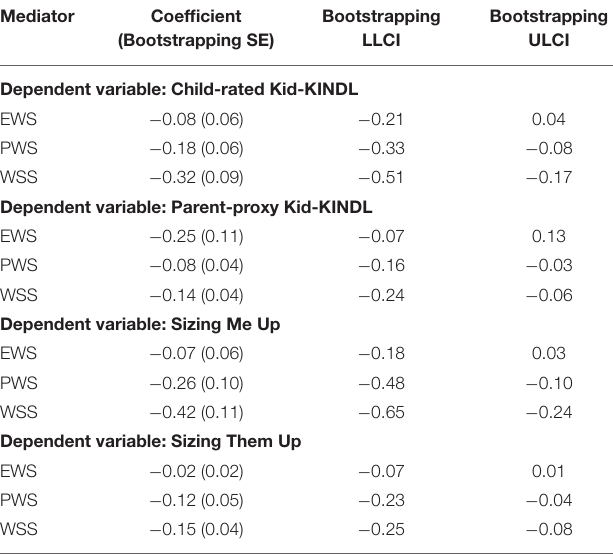
TABLE 5 | Mediation models testing the indirect effect of different types of weight stigma in the association between body weight and quality of life.